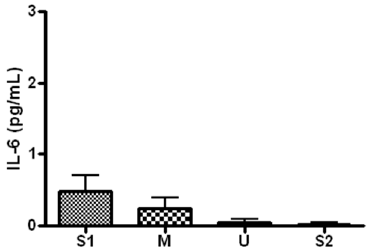
Figure 7. Serum IL-6 concentration in different locations. Values are mean ± S.D. S1: Before start in Seoul, M: Moscow U: Ulaanbaatar S2: Return to Seoul.